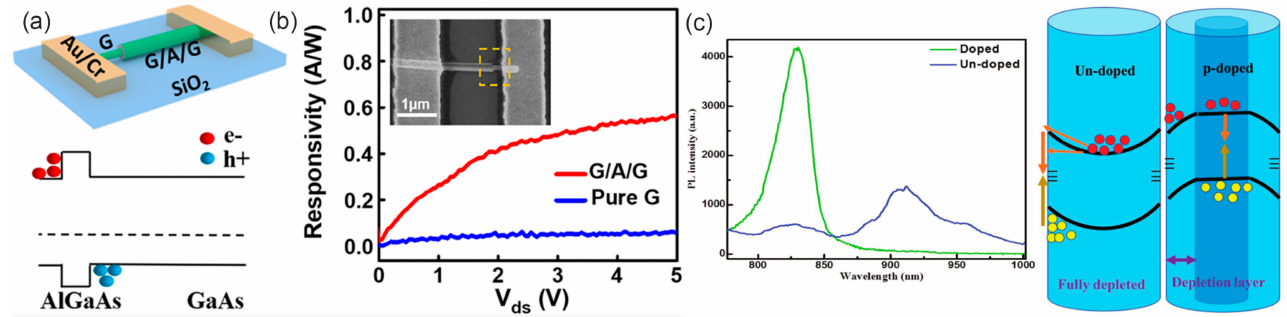
Figure 12. ( a ) Schematic of the G/A/G NW photodetector. ( b ) Energy band diagram of the G/A/G NW channel along the radial direction [136]. Copyright 2020, American Chemical Society. ( c ) Single NW PL spectra of doped and undoped GaAs NWs at 20 K and schematic depicting band-bending effects across the nanowire cross section for ( left ) undoped and ( right ) p-doped GaAs NWs [139]. Copyright 2018, WILEY-VCH Verlag GmbH & Co. KGaA,